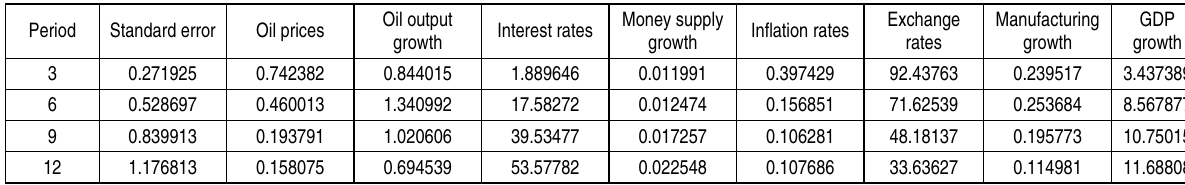
Table 4: Variance decomposition of exchange